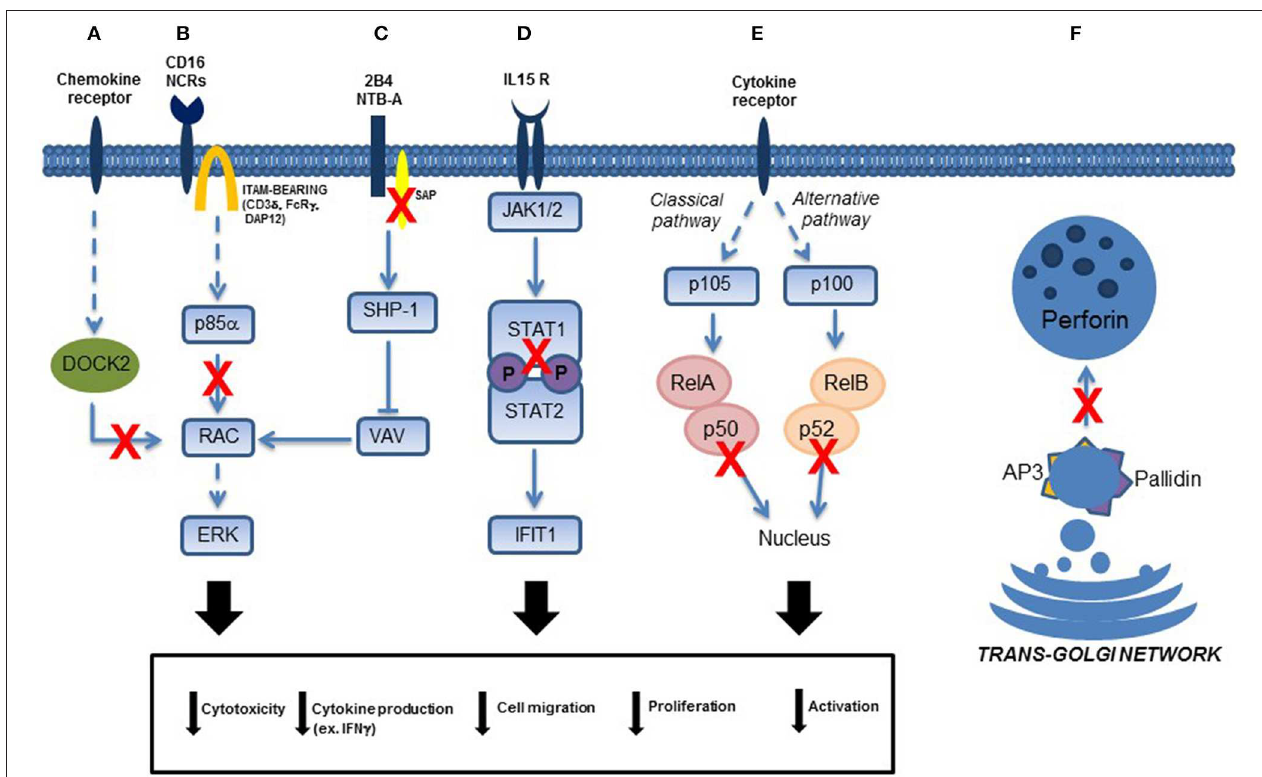
FIGURE 2 | Schematic representation of NK cell transduction pathways involved in primary immunodeficiencies. Functional NK cell defects due to: (A) DOCK2 mutations, (B) p85 α ( PIK3R1 ) mutations, (C) SAP ( SH2D1A gene) mutations in patients affected by XLP1, (D) STAT1 mutations, (E) p50 (in the canonical pathway of NF- κ B signaling) and p52 (in the alternative pathway of NF κ B signaling) mutations, and (F) AP-3 and Pallidin mutations in patients affected by Hermansky-Pudlak type 2 and 9, respectively. Direct and indirect effects on signaling are represented with continued or dotted lines,